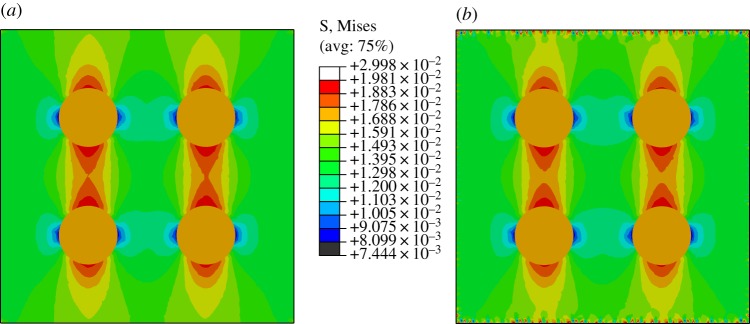
Distribution of Von Mises stress when the traditional method (a) and the new method (b) with 80 control points are used to impose periodic boundary conditions subject to a vertical tensile strain of 10%. In both cases the mesh contains 100 nodes at each side. It should be noted that the maximum Von Mises stress is present at the upper and lower boundaries and the area affected by those values is comparatively small to the rest of the RVE as shown in this figure. (Online version in colour.)